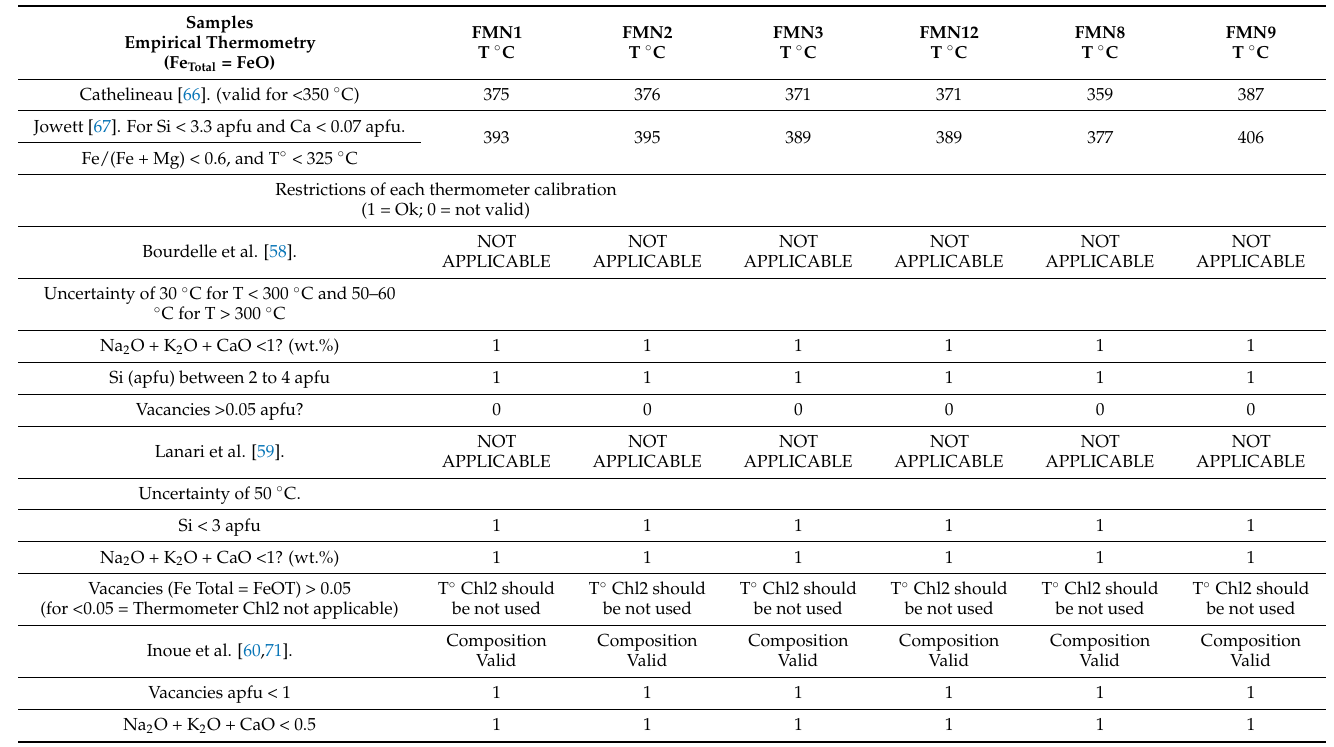
Table 7. Calculated temperatures using empirical thermometry